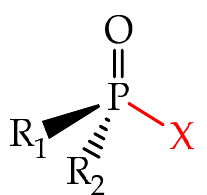
Figure 3. General structure of organophosphorus compounds.